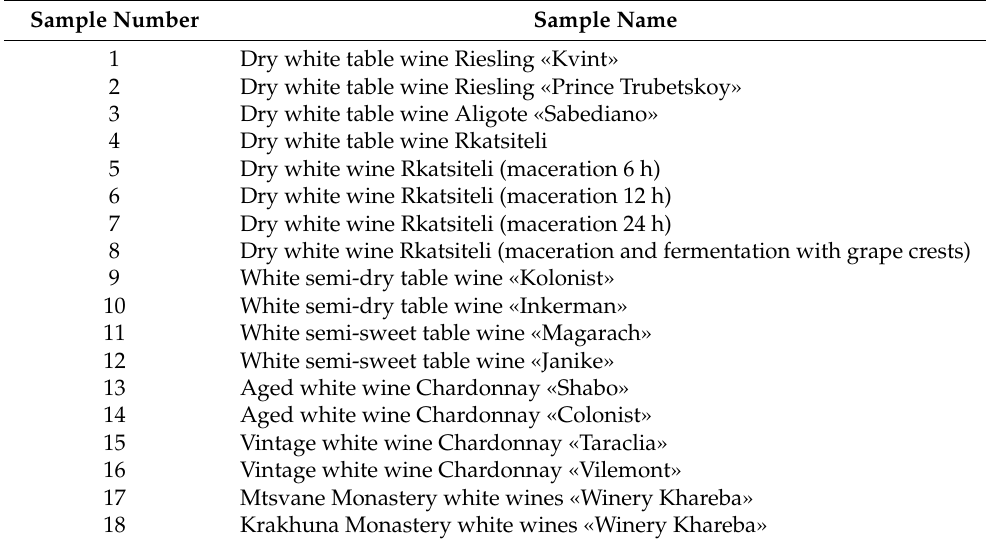
Table 3. Names of samples of dry white wines.